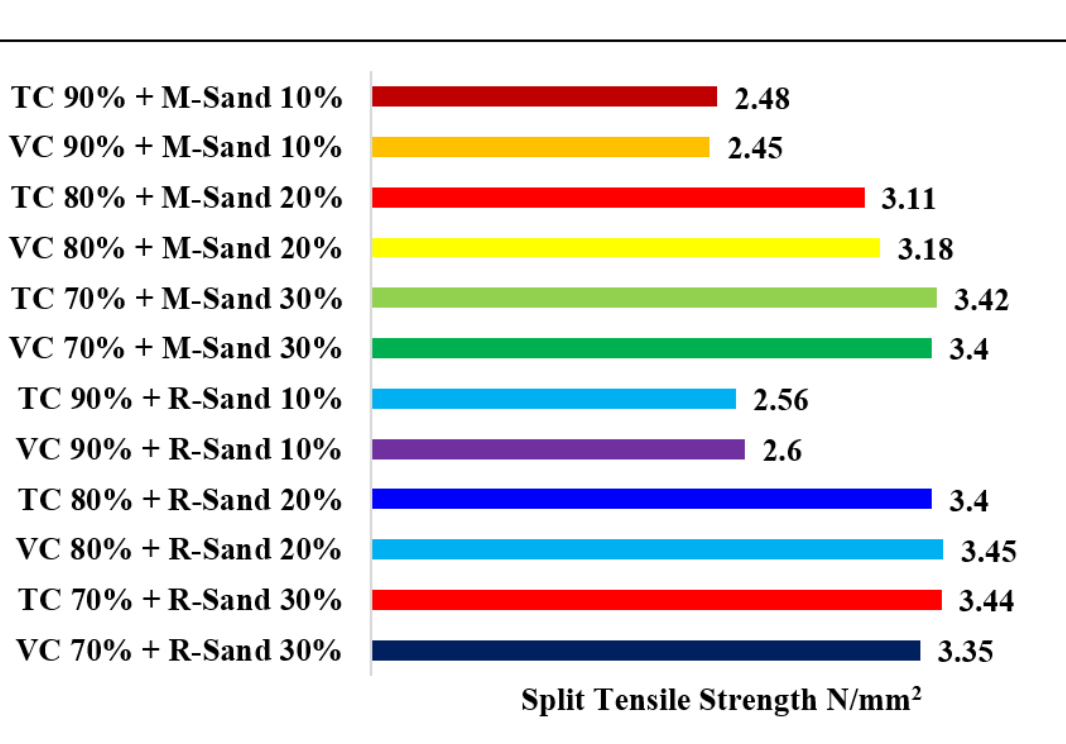
Figure 16. Split tensile strength of modified concrete with partial replacement of silica sand.